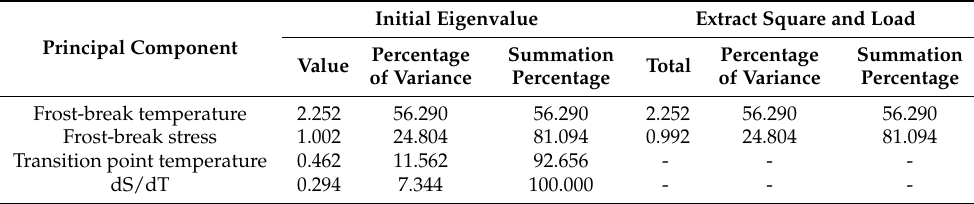
Table 7. Variance decomposition principal component extraction analysis results.